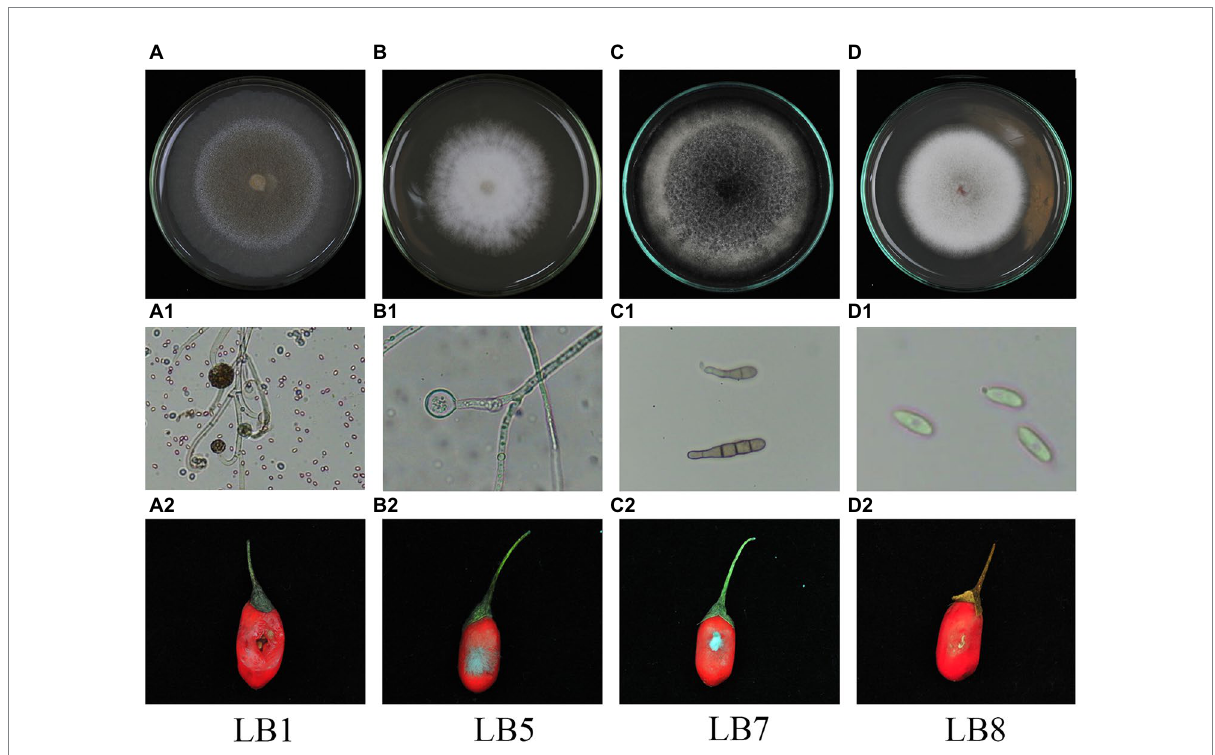
FIGURE 1 Morphological characteristics and pathogenicity detection of pathogenic strains of wolfberry after harvest ( A–D : surface morphology of pathogenic strains, A1–D1 : hyphae and spore morphology of pathogenic strains in microscopic morphology, A2–D2 : observation of pathogenicity of pathogenic strains on